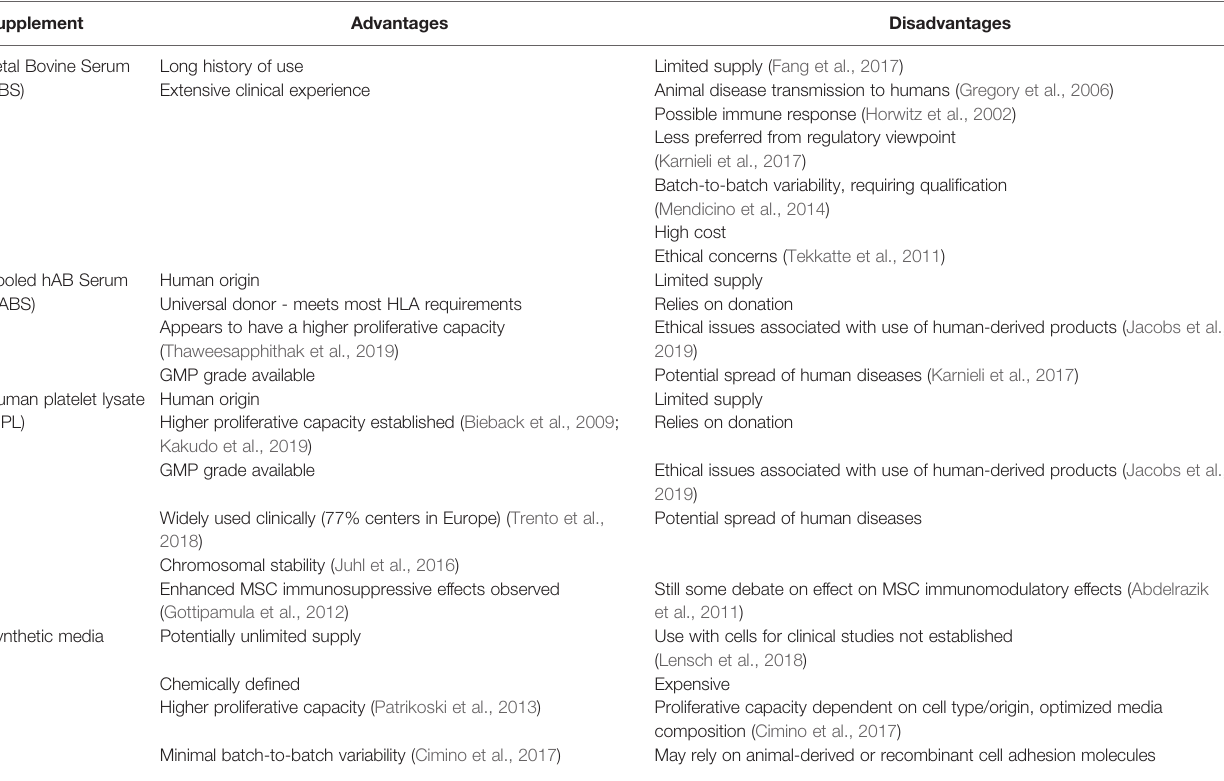
TABLE 1 | Summary of cell culture media growth supplements commonly used; fetal bovine serum (FBS), pooled human AB serum (hABS), human platelet lysate (HPL), and synthetic media and their relative advantages and disadvantages in a cell therapy